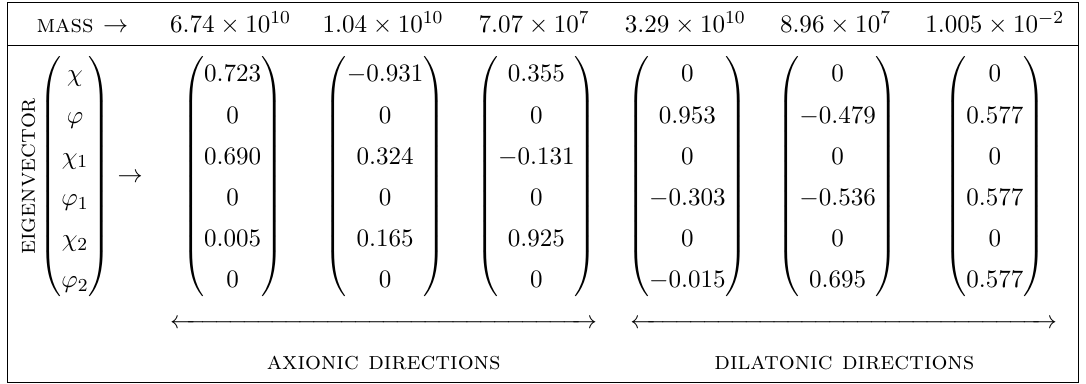
Table 8 . Mass spectrum of the de Sitter solution for the numerical example discussed in section 4. The complex (cid:12)elds S, T and U are parametrized as in (4.6), e 1 = 1 and N = 2